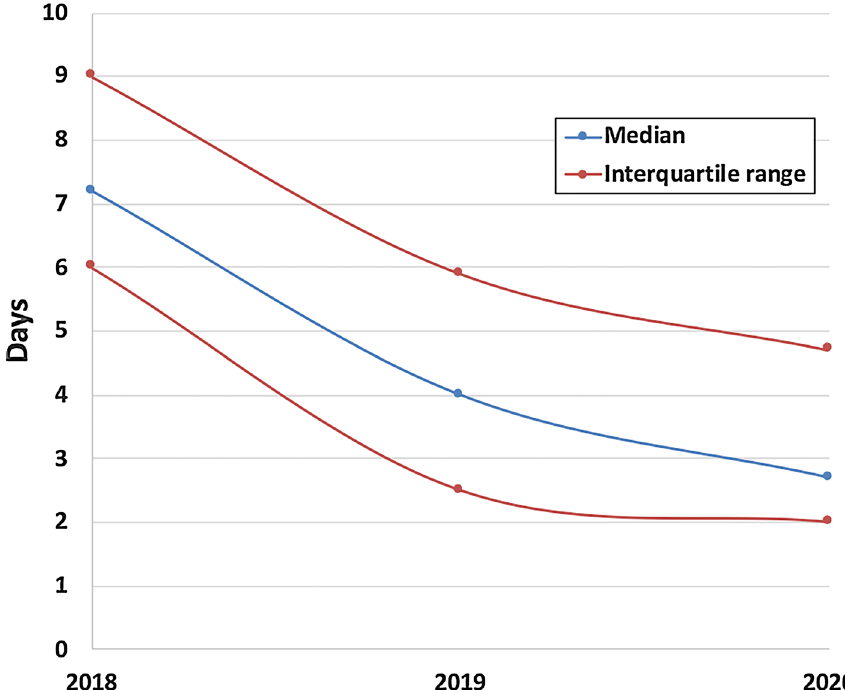
Figure 1. TAT improvement over the study period.